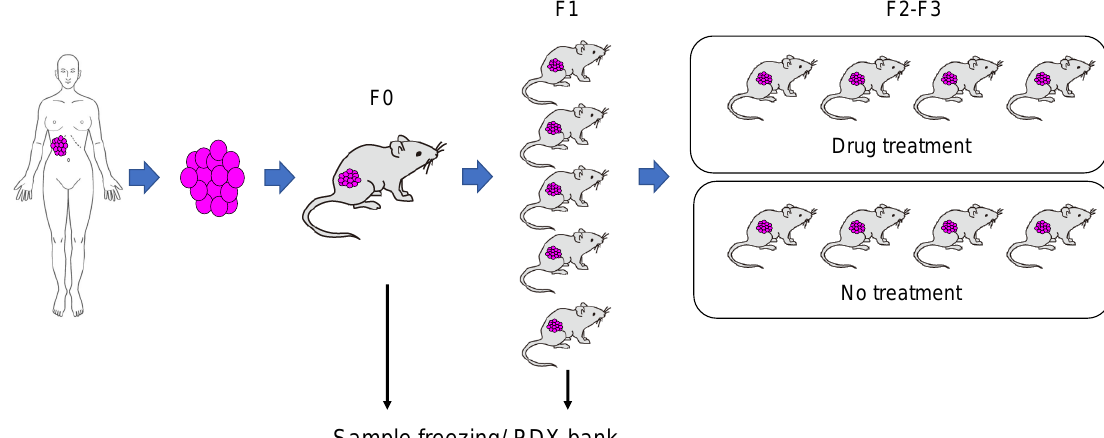
Figure 1. The grafting of patient-derived tumor cells into intensely immunodeficient mice leads to tumor growth in the mice within several months. The expanded tumor is excised. Part of the tumor is frozen, and the other part is grafted into intensely immunodeficient mice. These tumors are grafted again into intensely immunodeficient mice to conduct pathophysiological studies and evaluate drug efficacy. If the frozen patient-derived xenograft (PDX) tumor is registered with the PDX bank and a database of genetic analysis data and drug sensitivity data is created, it is expected to facilitate precision cancer medicine corresponding to the characteristics of the tumor in a given case.